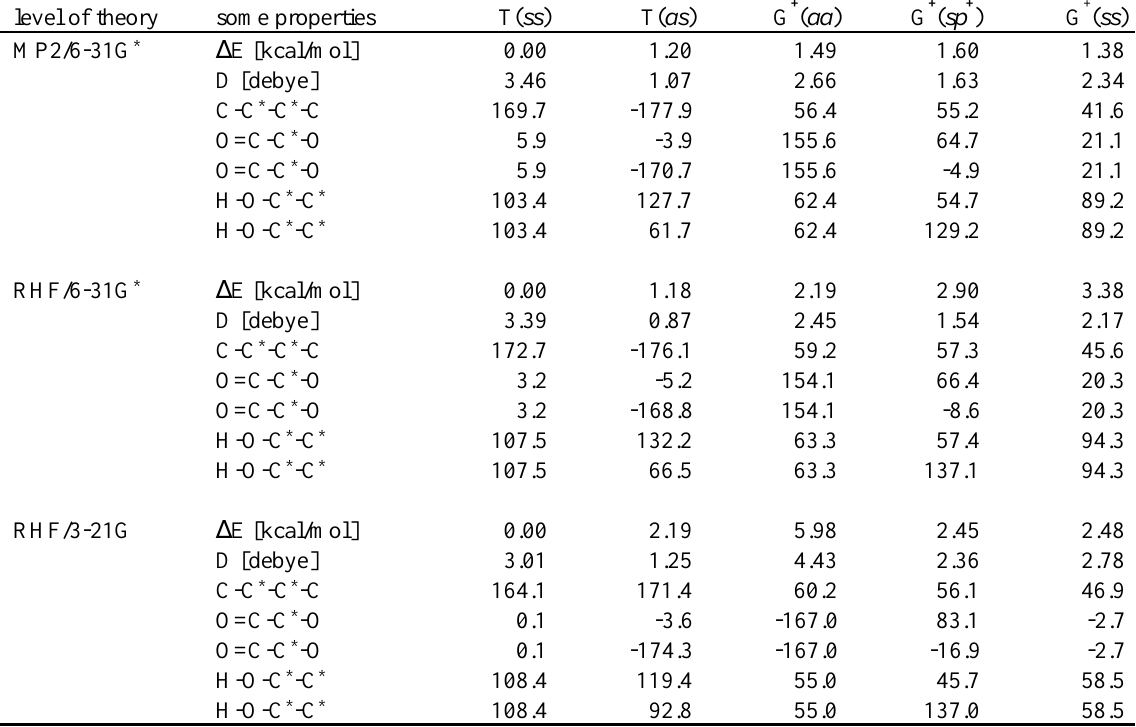
Table 5. Ab-initio results for dimethyl